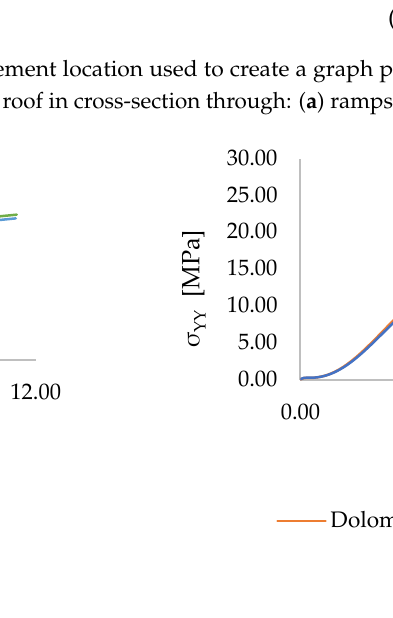
Figure 10. Distribution of σ YY stresses acting on the excavation roof in the cross-section through the ( a ) ramps and ( b ) entries drilled in sandstone and